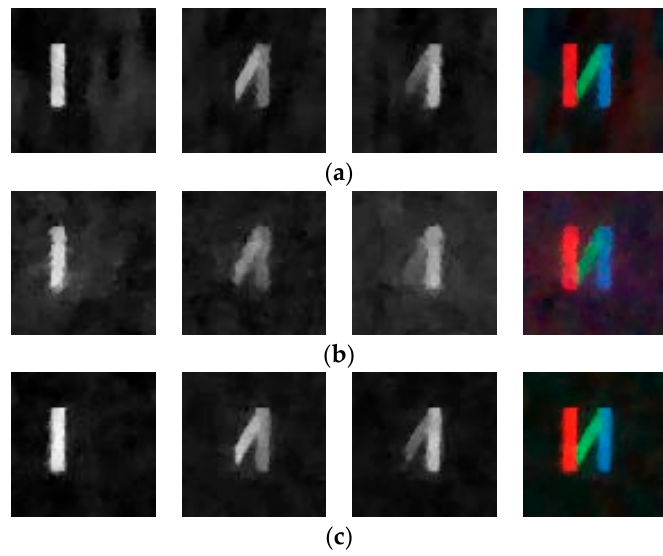
Figure 7. Results obtained by the single-pixel color camera, and the target image is color letter N: ( a ) recovered images using LCS-MM, PSNR = 19.80 dB, SSIM = 0.19; ( b ) recovered images using LCS-CMM, PSNR = 18.18 dB, SSIM = 0.08; ( c ) recovered images using LCS-PRC-MM, PSNR = 20.17 dB, SSIM = 0.20.